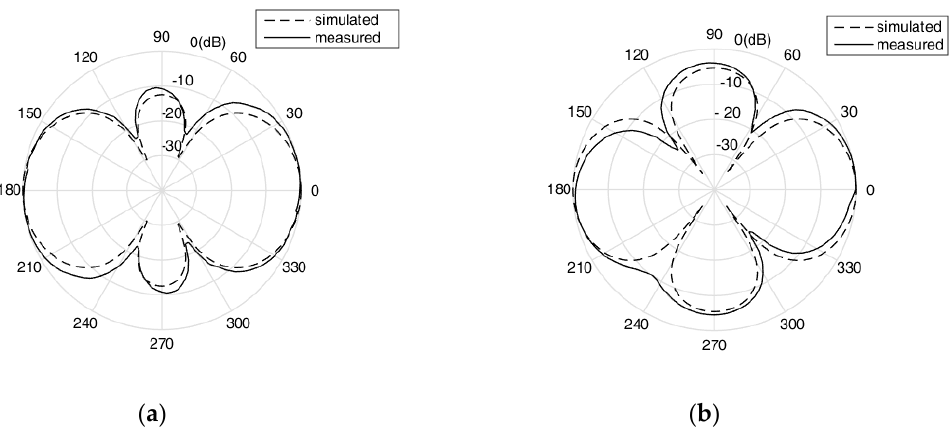
Figure 6. ( a ) The simulated and measured results of the radiation directivity before optimization. ( b ) The simulated and measured results of the radiation directivity after optimization. The solid and dotted lines are the measured and simulated results, respectively.